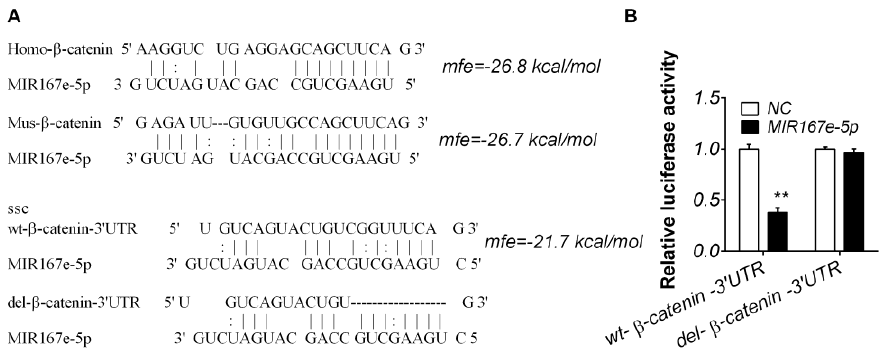
Figure 2. MIR167e- 5p targets β -catenin. ( A ) The predicted target β -catenin 3 ′ -UTR (untranslated region) and MIR167e-5p. Black lines and two-dotted labels represent the paired and G:U paired sequences for normal and 3 ′ -UTR- deleted β -catenin, respectively. Note that the potential binding site of MIR167e- 5p in the β -catenin 3 ′ -UTR is highly conserved across species. ( B ) HeLa cells were transfected with each of the constructed plasmids, together with MIR167e-5p or NC. MIR167e-5p significantly decreased luciferase activity in cells transfected with wild- type (wt) β -catenin but not in cells transfected with 3 ′ -UTR- deleted β -catenin (firefly luciferase activity/Renilla luciferase activity, ** p < 0.01, n = 8).